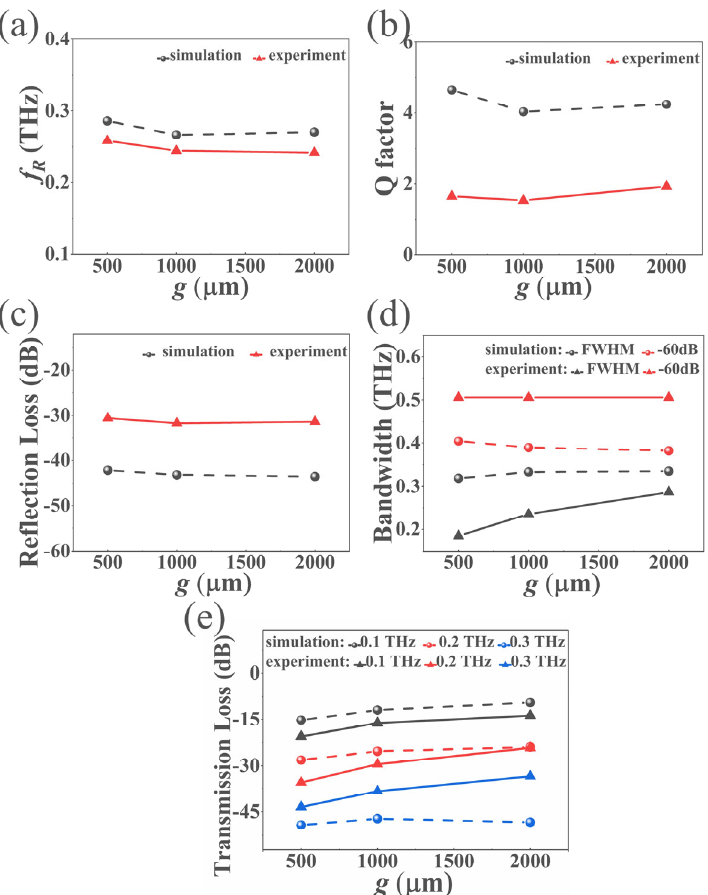
Figure 5. Characteristics of the THz PC waveguide. Influence of the gap distance ( g ) on ( a ) the resonant frequency f R , ( b ) Q factor, ( c ) the reflection loss (at f = f R ), ( d ) the bandwidth (with FWHM and − 60 dB bandwidth, respectively), and ( e ) the transmission loss with f = 0.1 THz, f = 0.2 THz, and f = 0.3 THz,